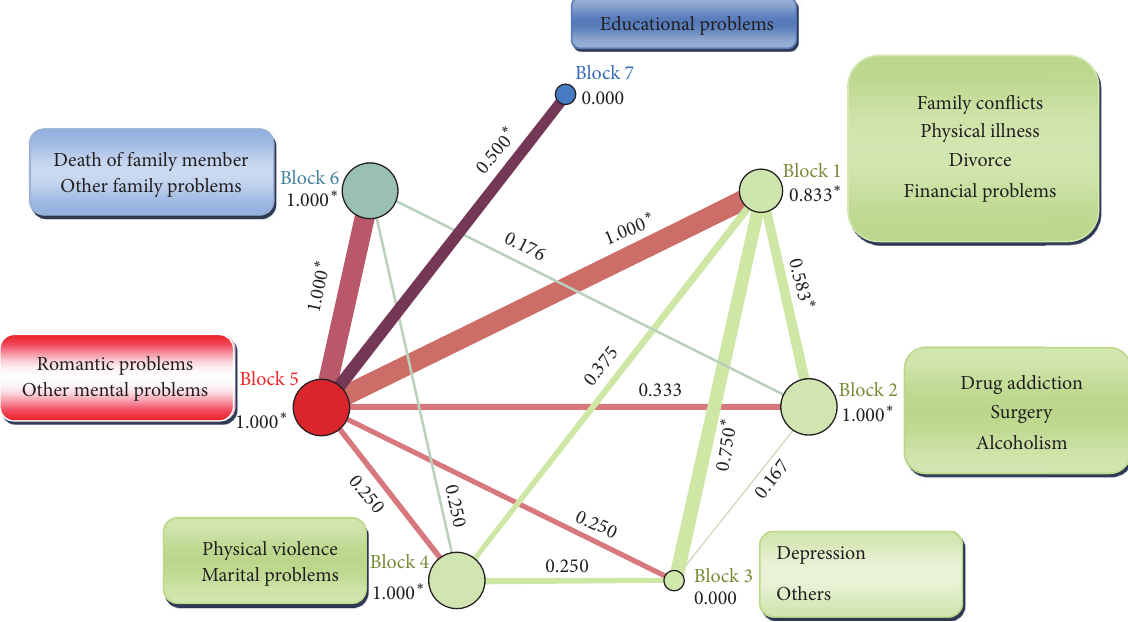
Figure 3: Block modelling in the network of problems preceding deliberate self-poisoning among women. ∗ Density scores higher than the score of whole